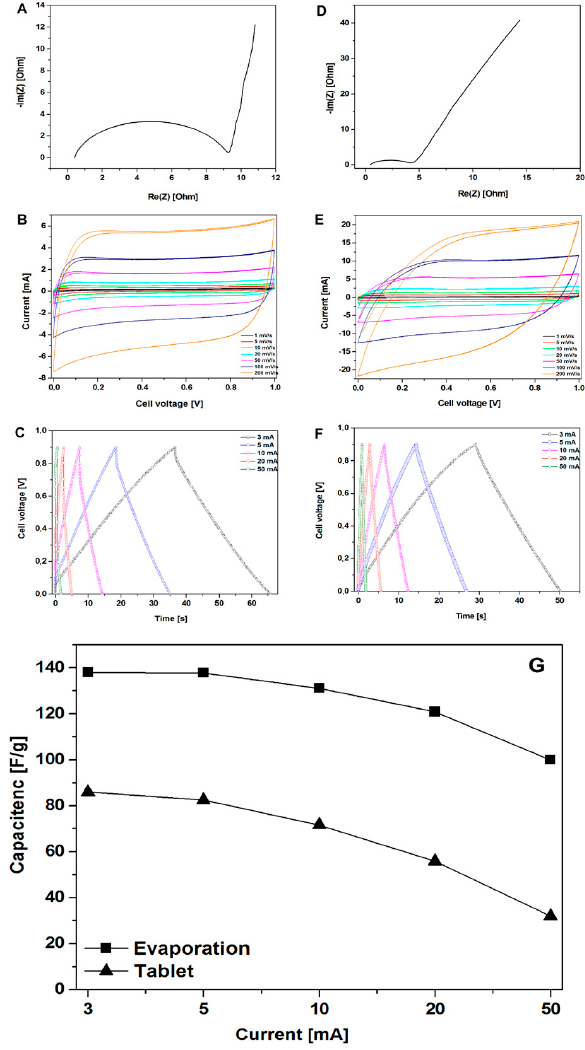
Figure 4. The Nyquist plots, CV, and GCD curves of the electrodes prepared by evaporation ( A – C ) and pellet formation ( D – F ) along with the measured specific capacitance (calculated from the GCD curves) for the electrodes prepared by evaporation and pellet formation ( G ).